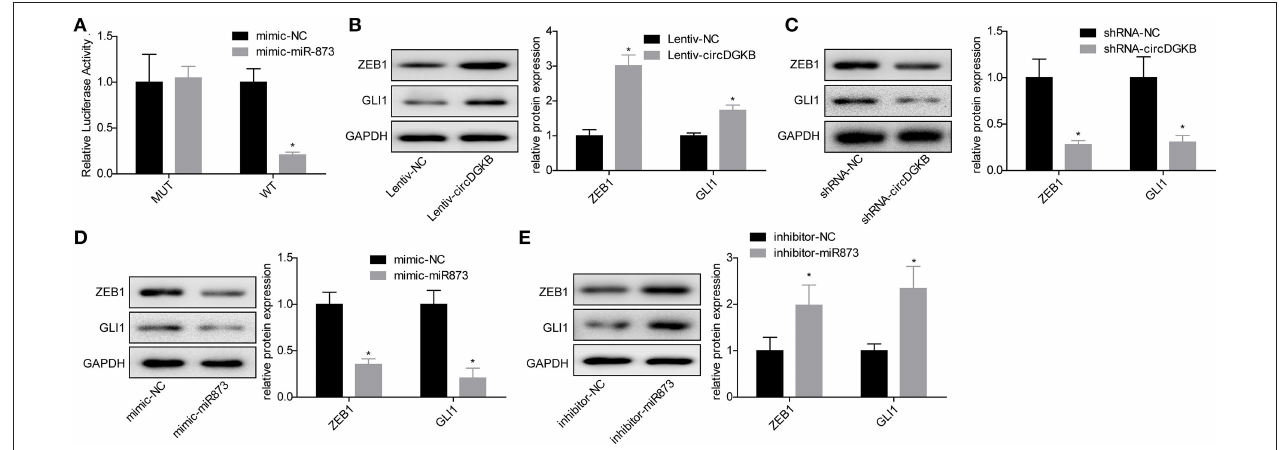
FIGURE 4 | circDGKB targeted miR-873/GLI1 axis in NB SK-N-SH cells. (A) Luciferase reporter gene assay was adopted to confirm the interaction between circDGKB and miR-873. (B) Western blot was taken to calculate the relative protein levels of ZEB1 and GLI1 in SK-N-SH cells after circDGKB overexpression, * P < 0.05. (C) Relative protein levels of ZEB1 and GLI1 in SK-N-SH cells were detected following circDGKB downregulation, * P < 0.05. (D) Relative protein levels of ZEB1 and GLI1 in SK-N-SH cells were calculated after miR-873 was upregulated, * P < 0.05. (E) Relative protein levels of ZEB1 and GLI1 in SK-N-SH cells were examined by western blot after miR-873 was downregulated, * P < 0.05.